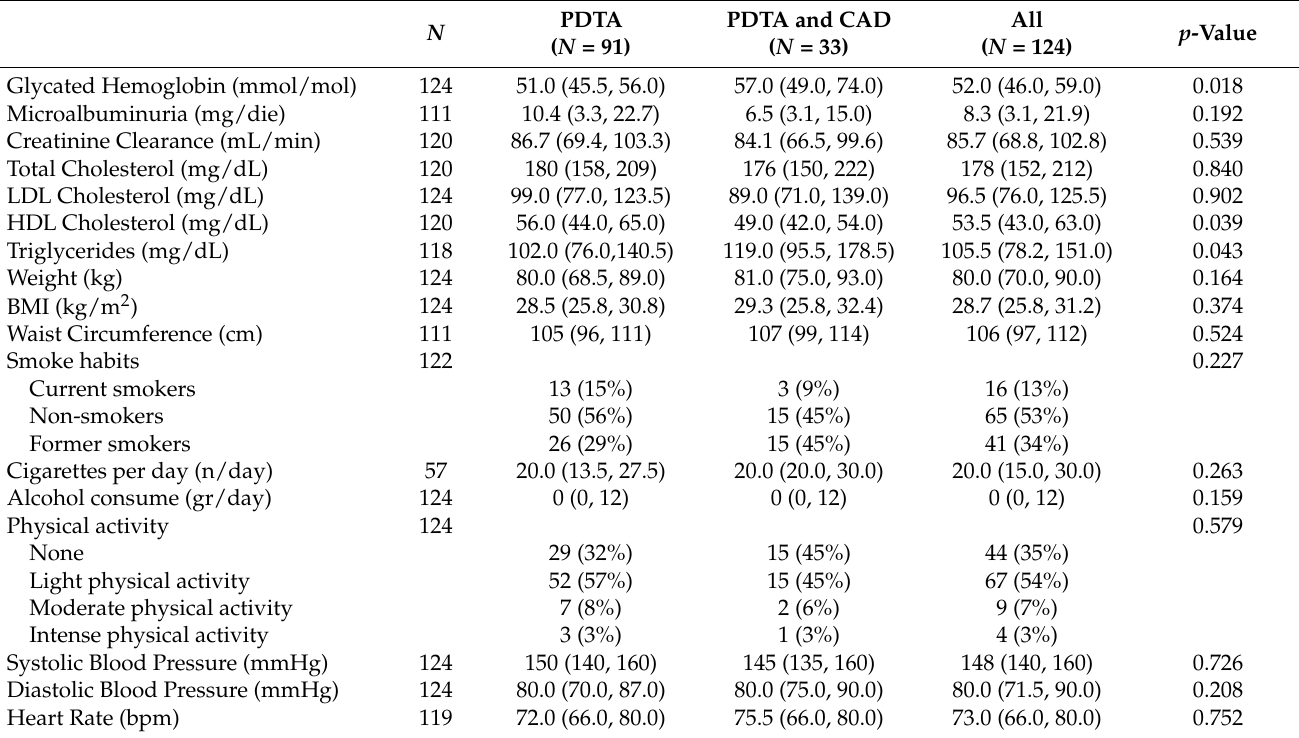
Table 2. Descriptive table on biochemical data and clinical information collected during baseline PDTA examination. Data are expressed as median (I, III quartile) for continuous variables and absolute numbers (percentage) for categorical variables.